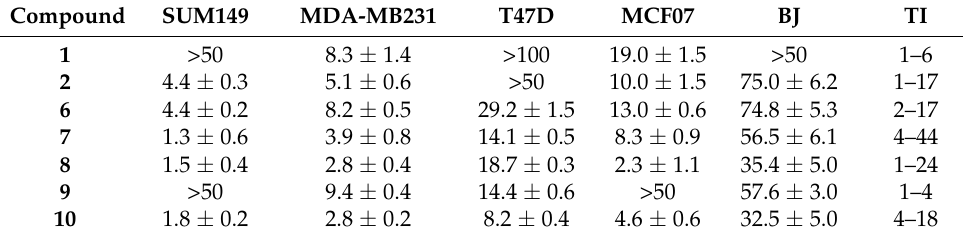
Table 1. Cytotoxicity (IC 50 in μ M) semisynthetic abietanes 1–2 and 6–10 after 72 h of incubation.